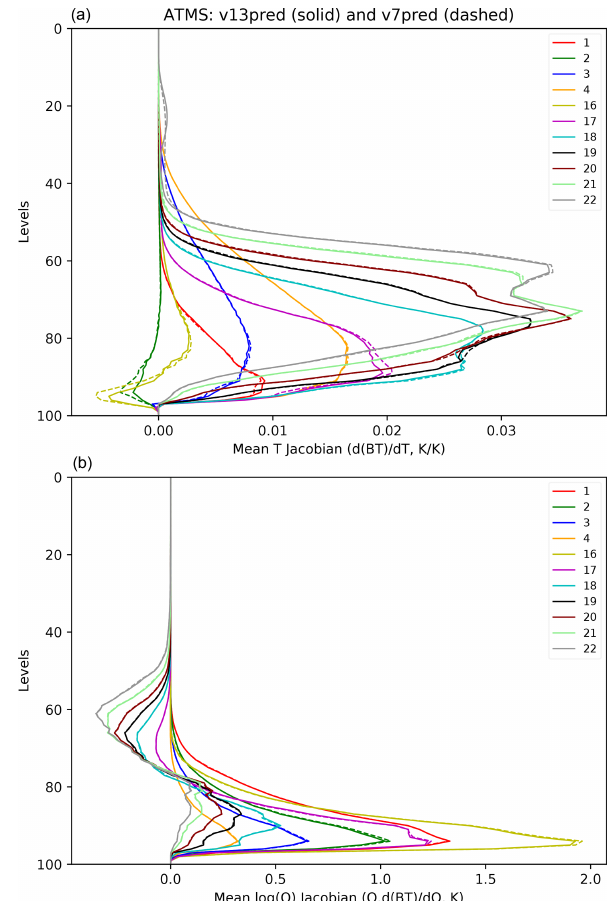
Figure 10. Mean ATMS temperature (a) and water vapour (b) Ja- cobians for v13 predictors (solid lines) and v7 predictors (dashed lines) for the 83 training profiles. A subset of channels for which the differences are largest are